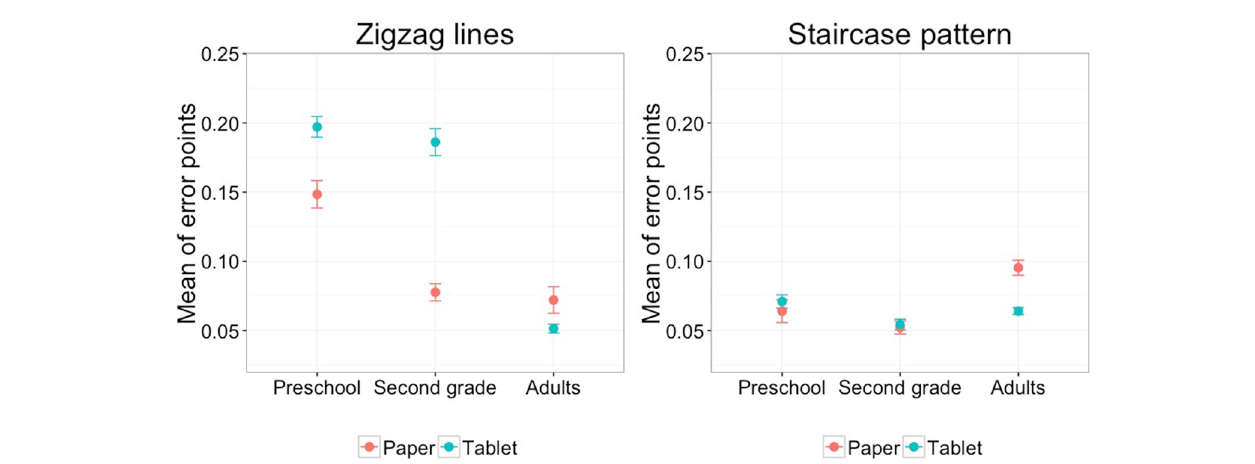
FIGURE 4 | The significant interaction between medium and group for the error points of zigzag lines and the staircase pattern (with standard errors). The writing duration was longer on paper than on tablet for loops without dots for the preschool children ( p = 0.012), for loops with dots for the adults ( p = 0.026), and for zigzag lines for the two children groups (preschool: p = 0.025; second grade: p = 0.039). Regarding in air time we found longer in air times without dots for the preschool children ( p = 0.039) 1 .